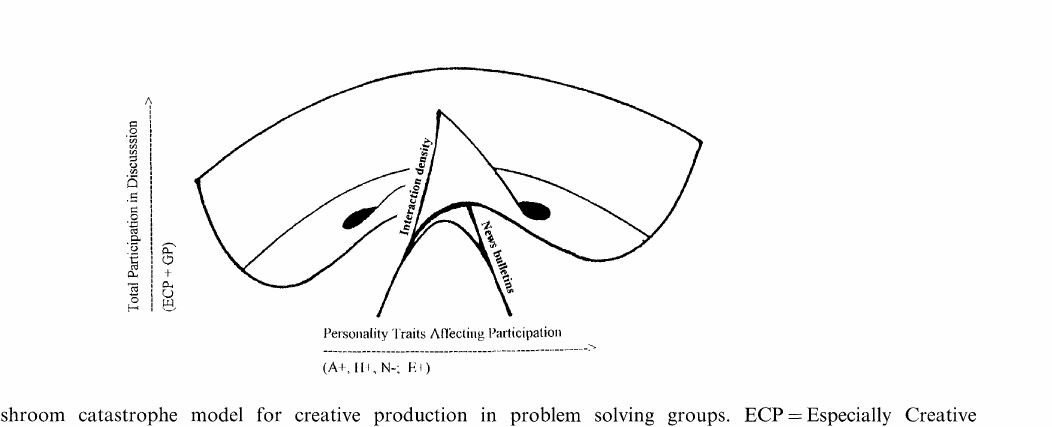
FIGURE 7 Mushroom catastrophe model for creative production in problem solving groups. ECP Especially Creative Participation; GP General Participation; A/ warmth and participativeness; H + social boldness;